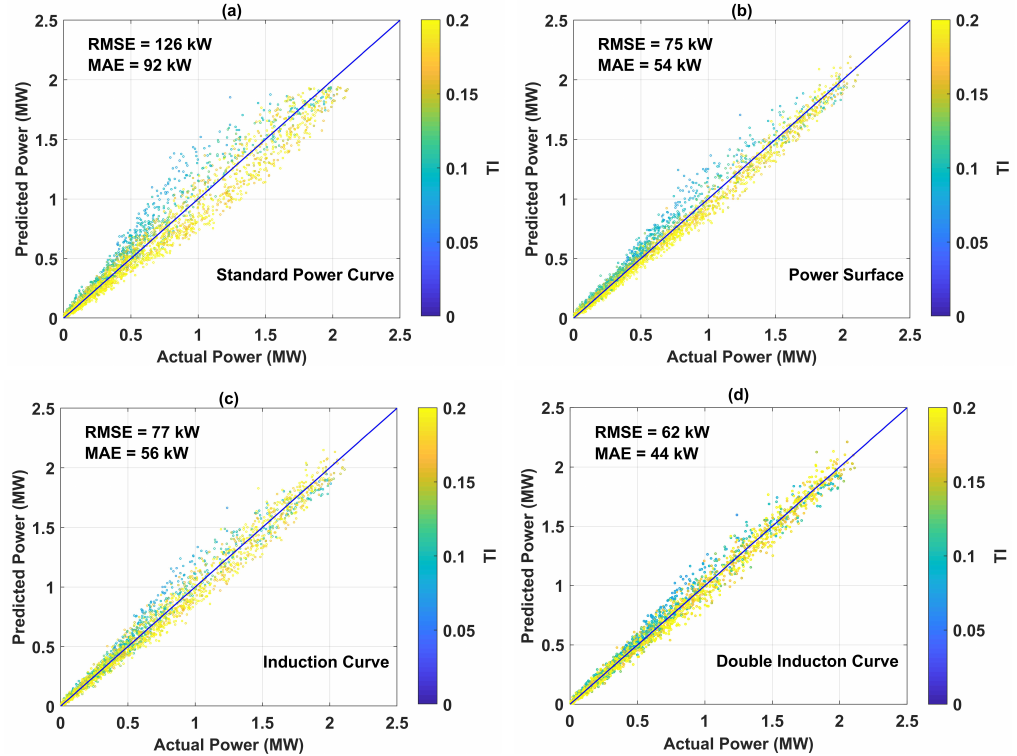
Figure 15. Performance of: ( a ) standard power curve, ( b ) power surface, ( c ) induction curve, and ( d ) double induction curve, for predicting power generation of the wind